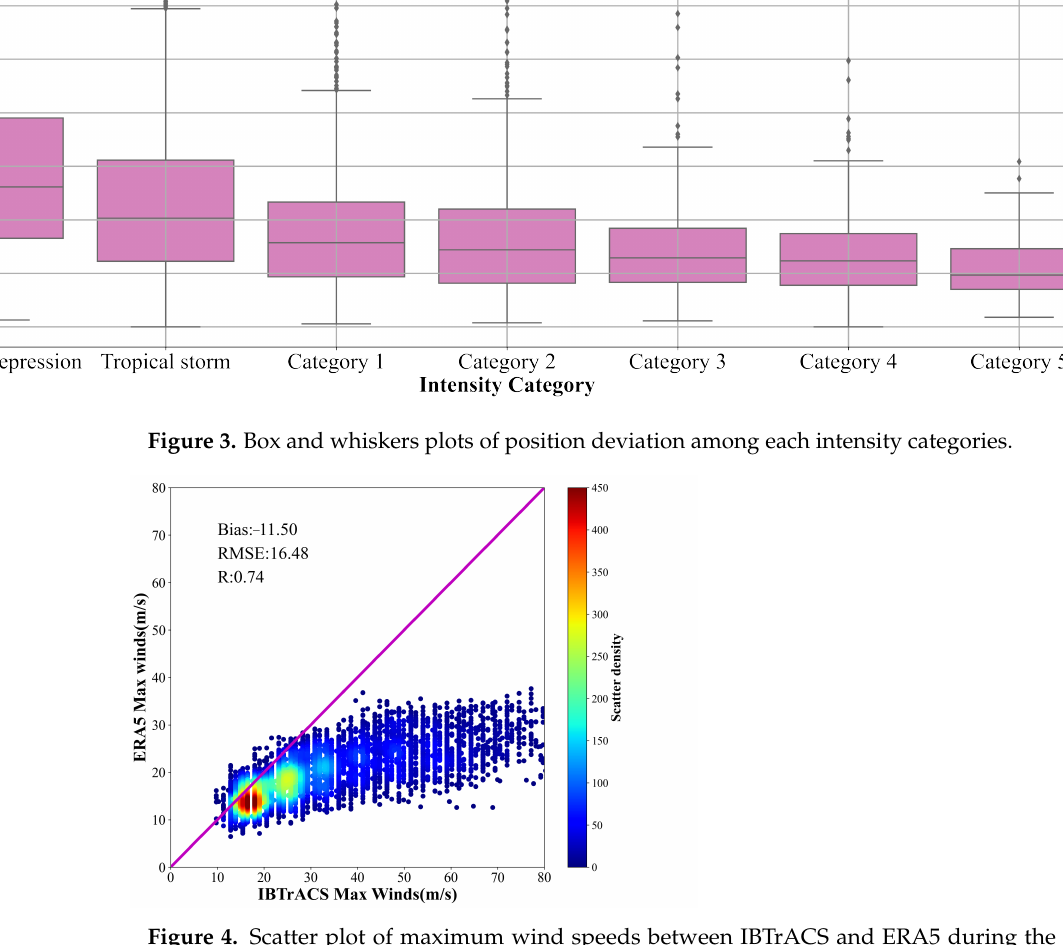
Figure 4. Scatter plot of maximum wind speeds between IBTrACS and ERA5 during the period 2018–2020. The color scale is the number of data